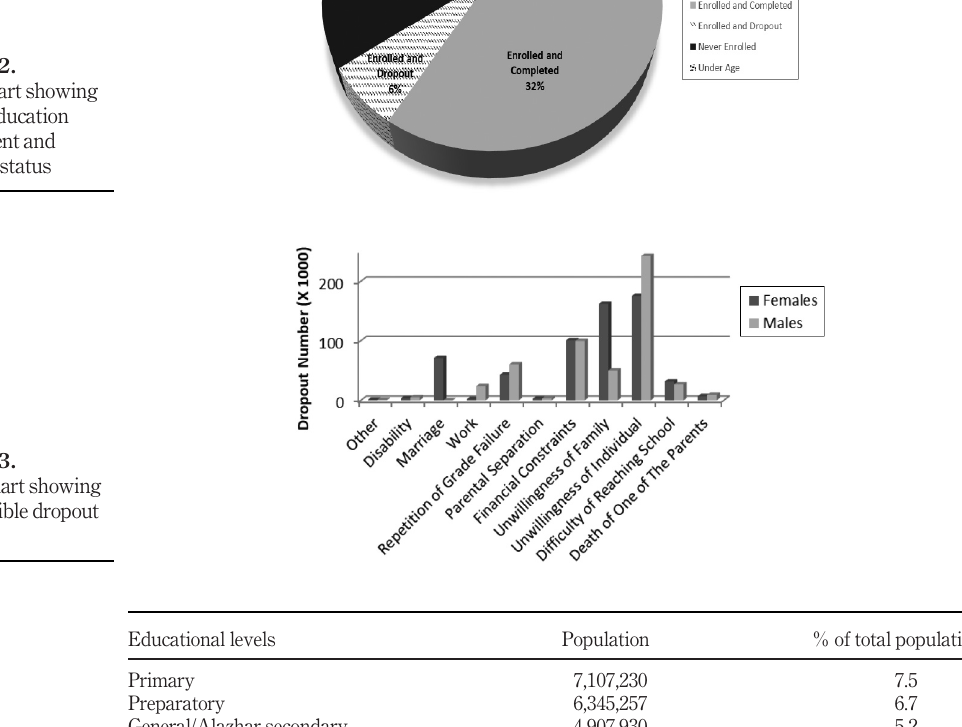
Figure 2. A pie chart showing